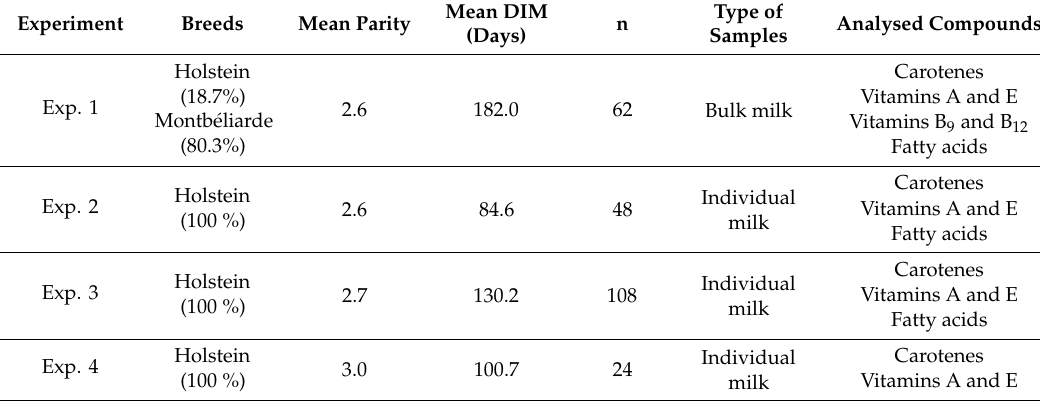
Table 1. Summary of the source of all data, herds characteristics, type of samples and analysed compounds according to the